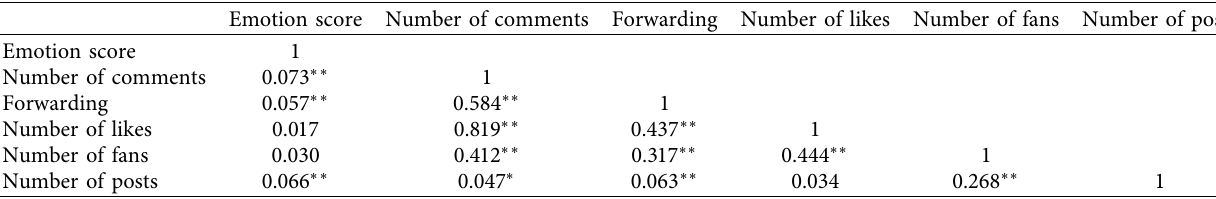
Table 3: Correlation analysis between prosocial emotion and the number of comments.